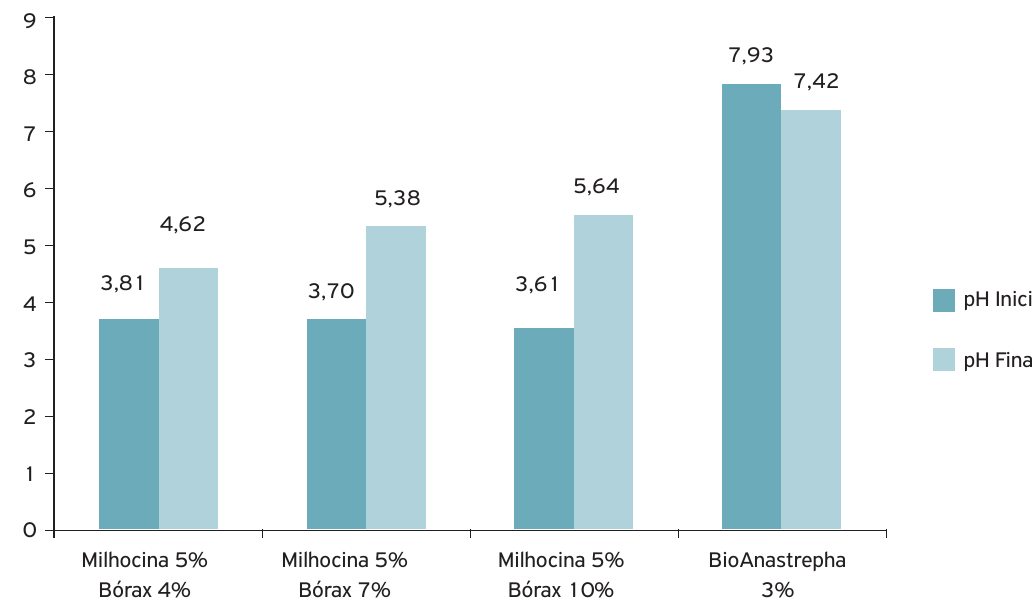
Figura 1. Valores médios de pH no início e final do período de exposição (0 a 10 dias) de diferentes atrativos em armadilhas McPhail, em condições de semicampo. Campinas, São Paulo, janeiro a fevereiro de